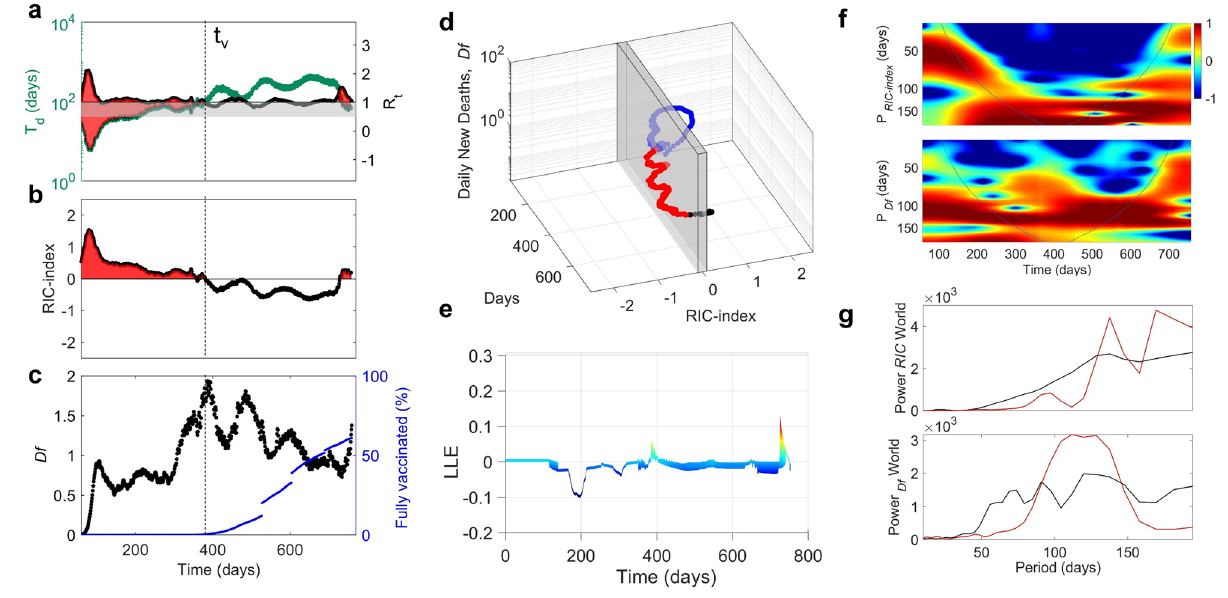
Figure 1. T d , R t , RIC-index and daily fatalities per million populations ( Df ) of the epidemic spreading in all worldwide from 15/03/2020 to 28/01/2022. ( a ) Plots of the time dependent doubling time, T d , (green dots) and reproductive rate R t (black dots) in the world from 15/03/2020 to 28/01/2022. The gray region below R t = 1 represents the critical region separating the supercritical (T d < 50, R t > 1) from the subcritical (T d > 100, R t < 1). The supercritical phases correspond to the red areas. The vaccination campaign starts at t = t v = 350 day (dotted vertical line) corresponding to 15/12/2020. ( b ) The RIC index (black dots) vs. time. The supercritical phases occur for positive values of the RIC index, indicated by the red areas. ( c ) Daily new deaths per million of population (full circles) and percentage of fully vaccinated peoples (blue line) vs. time. ( d ) 3D orbit of the Covid-19 vortex over two years where the daily new deaths per million population and the RIC-index (days) are plotted as a function of time measured in days starting from the 75 day of the year 2020. The gray shaded plane represents the critical crossover at the zero RIC index, which separates the supercritical RIC -index > 0 and the subcritical regime RIC index < 0. ( e ) Lyapunov map showing the transition from convergent to divergent trajectories, i.e., the instability zones where the Larger Lyapunov Exponent (LLE) becomes positive. (f) Local wavelet power spectrum, obtained from the Wavelet transform of the RIC index and daily deaths per million population (Df) time series. We can observe the evolution of the main periods. We note a shift towards longer periods with the activation of the vaccination campaign in both RIC index and Df time series. We can also visualize short lived transient events during the pandemic spreading, corresponding to lower intensity spots at small periods. Power is color coded from − 1 (blue) to 1 (red). ( g ) The Global Wavelet Power Spectrum (GWPS) of the period of epidemic periodic traveling waves for infections measured by the RIC index and Df (solid black line), before the vaccination campaign for t < t v (blue line) and after the onset of the vaccination campaign for t > t v (red